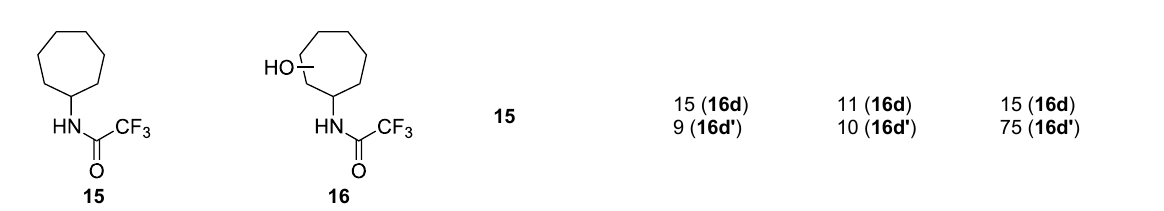
Table 1: Conversion (% relative peak-area by GC–MS of extracted reaction mixtures), after 24 h, of substrates 1 , 3 , 5 , and, after 48 h, of substrates 7 , 11 , 13 and 15 with P450cam-RhFRed mutants in 48-well plate biotransformations.